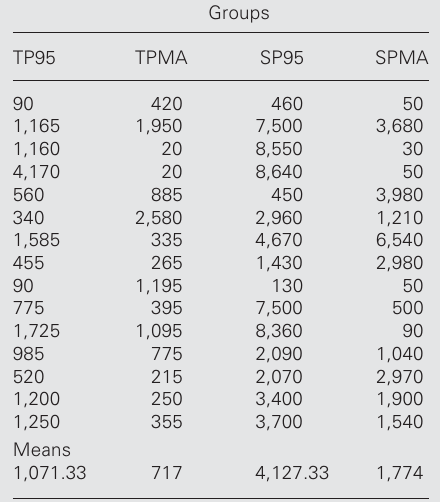
Table 2. Concentration in ng/µl of DNA extracted from the different samples (total volume of each, 20 µl).